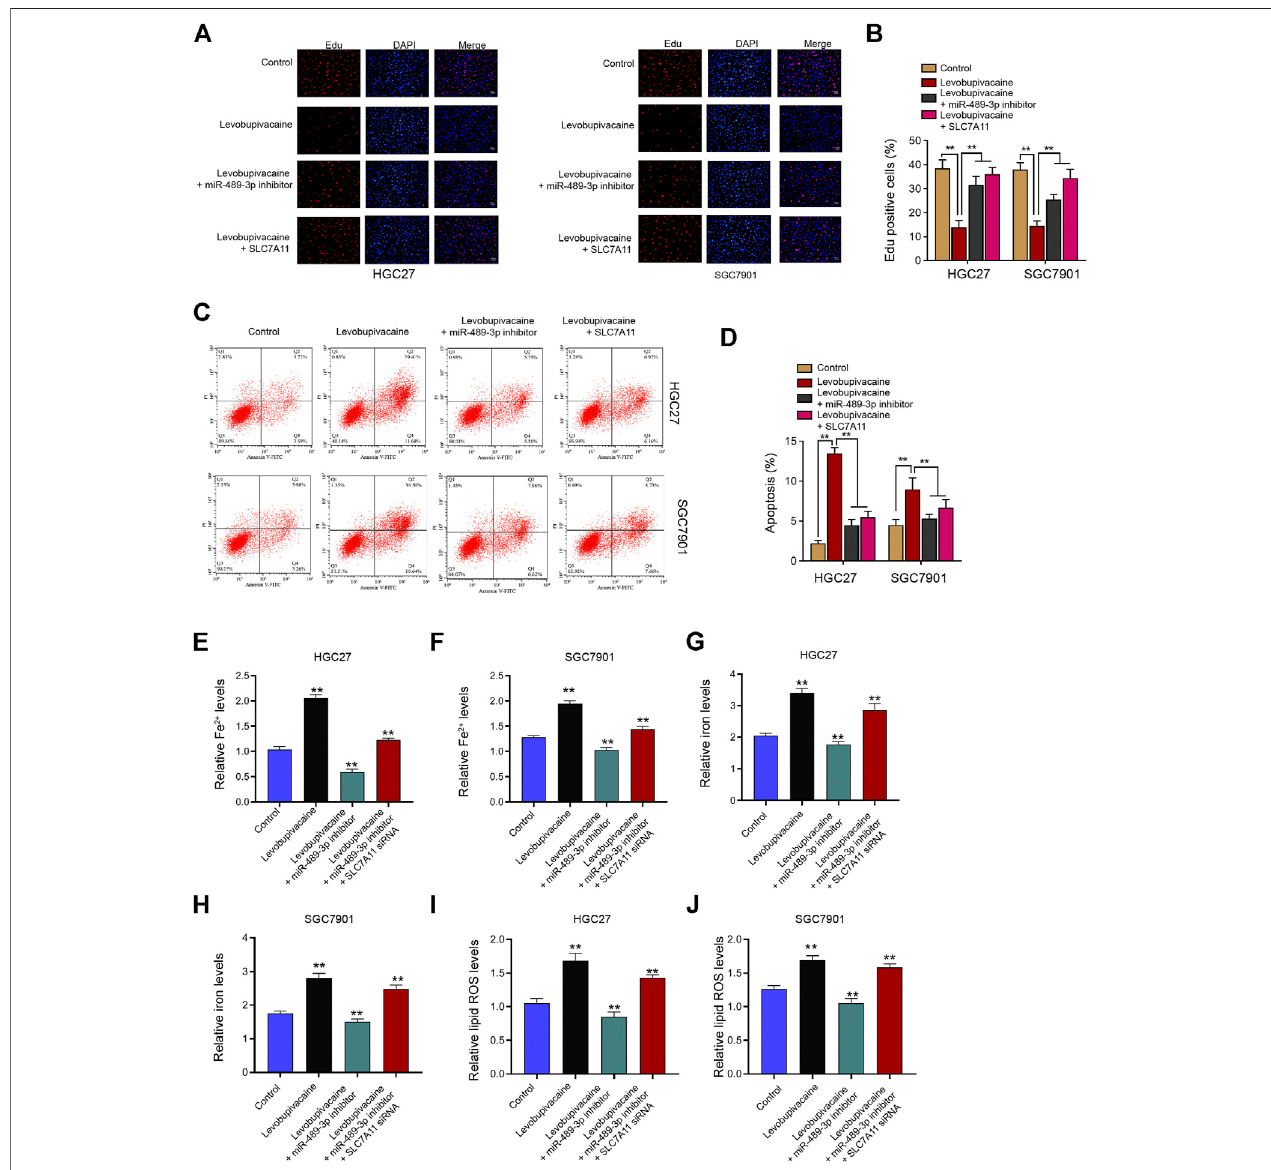
FIGURE 8 | Levobupivacaine/miR-489-3p/SLC7A11 axis attenuates gastric cancer cell proliferation in vitro . (A – D) HGC27 and SGC7901 cells were co-treated with levobupivacaine and SLC7A11 overexpression vectors or miR-489-3p inhibitor. (A,B) MTT assays for cell viability analysis. (C,D) Flow cytometry analysis of apoptosis. (E – J) HGC27 and SGC7901 cells were co-treated with levobupivacaine and miR-489-3p inhibitor or co-treated with levobupivacaine, miR-489-3p inhibitor, and SLC7A11 siRNA. The Fe 2+ (E,F) , iron (G,H) , and ROS levels (I,J) were analyzed. The experiments were performed independently three times (mean ± SD, ** p <